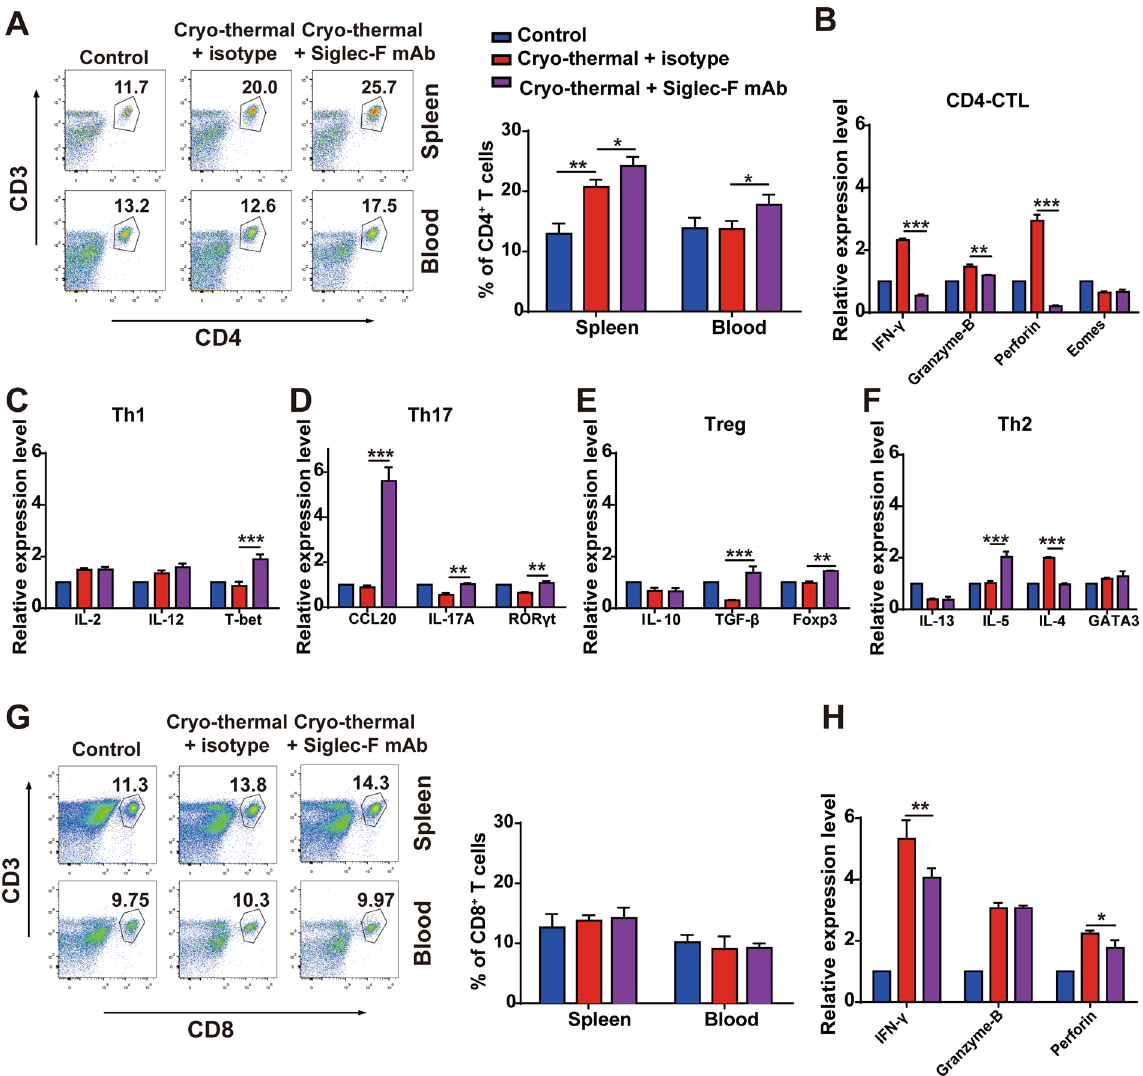
Figure 6. Cryo-thermal-activated eosinophils promoted the differentiation of CD4 + T cells and generation of cytotoxic CD8 + T cells. ( A ) The splenocytes and peripheral blood mononuclear cells were harvested from mice in cryo-thermal therapy + isotype, cryo-thermal therapy + Siglec-F mAb and control groups on day 14 after the treatment, and the percentage of CD3 + CD4 + T cells were analyzed by flow cytometry. The expression of CD4-CTL ( B ), Th1 ( C ), Th17 ( D ), Treg ( E ) and Th2 ( F ) cell subsets in splenic CD4 + T cells were assayed by RT- qPCR. ( G ) The splenocytes and peripheral blood mononuclear cells were harvested from mice in cryo-thermal therapy + isotype, cryo-thermal therapy + Siglec-F mAb and control groups on day 14 after the treatment, and the percentage of CD3 + CD8 + T cells were analyzed by flow cytometry. ( H ) The expression of IFN- γ , perforin and granzyme-B in splenic CD8 + T cells were assayed by RT-qPCR. n = 4 mice per group. Data was shown as mean ± SD. Data for bar graphs was calculated using student’s t-test ( A , G ) or two-way ANOVA ( B – F , H ). * p < 0.05; ** p < 0.01; *** p <